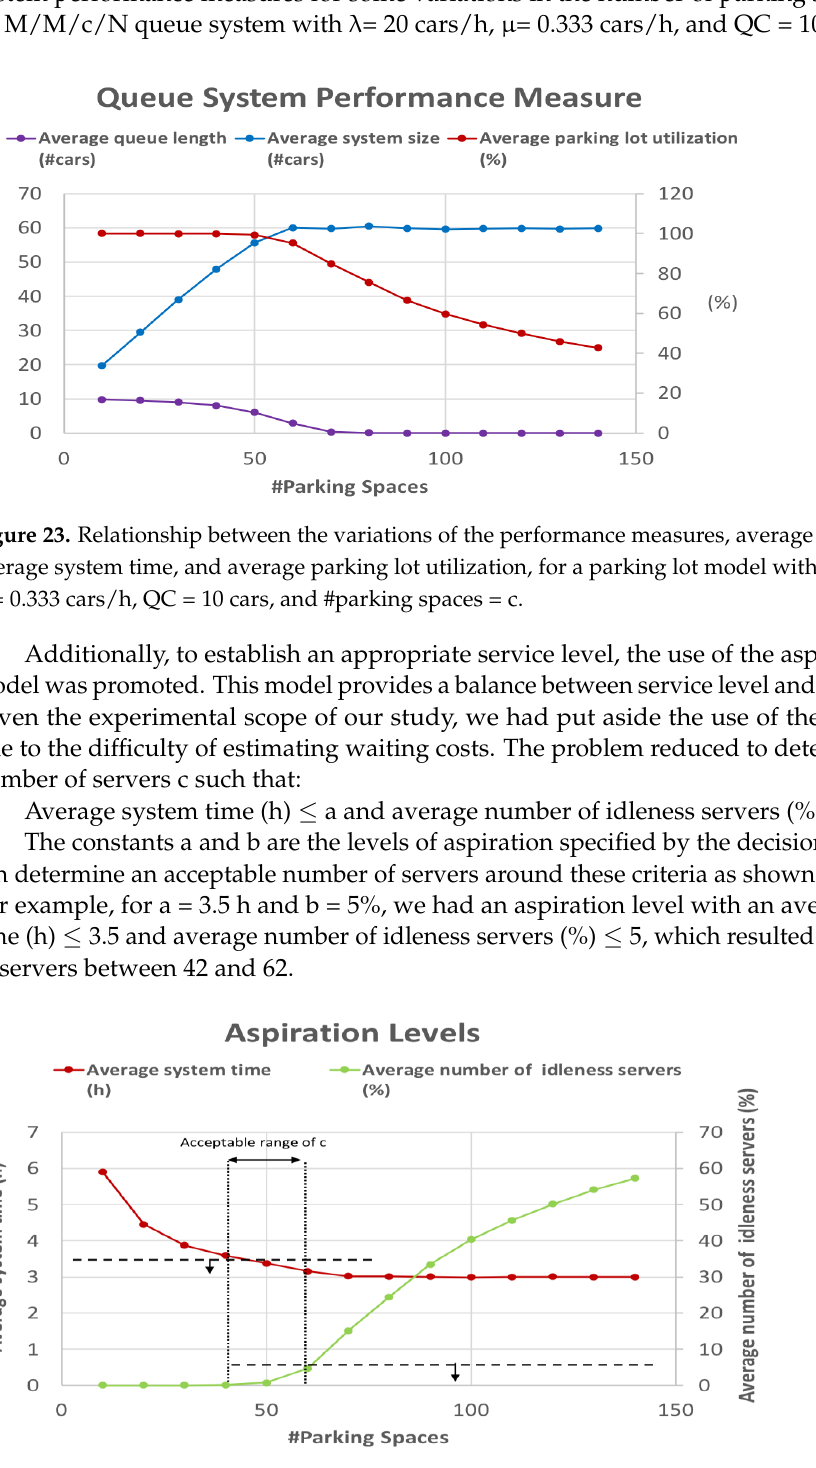
Figure 24. Estimation of the number of parking spaces required for a parking lot with λ = 20 cars/h, µ = 0.333 cars/h, and QC = 10 cars for aspiration level criteria: average system time (h) ≤ 3.5 and average number of idleness servers (%) ≤ 5.